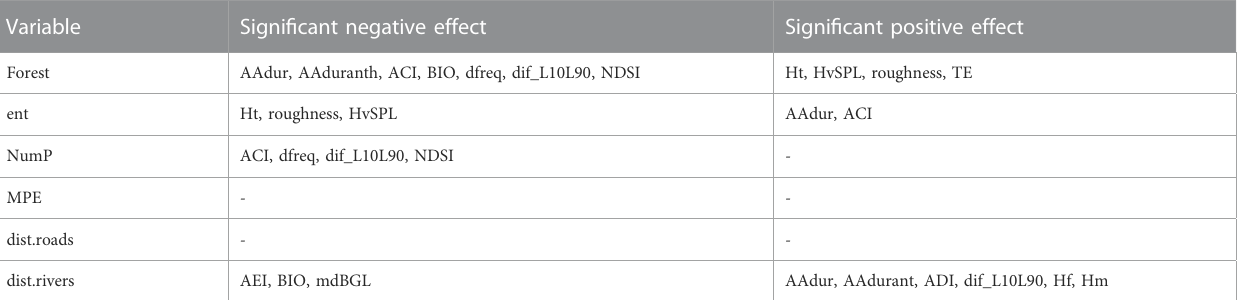
TABLE 5 Acoustic indices with a positive or negative statistically signi fi cant effect on each landscape variable in the Central Conservation Area of Costa Rica, 2019 – 2020.